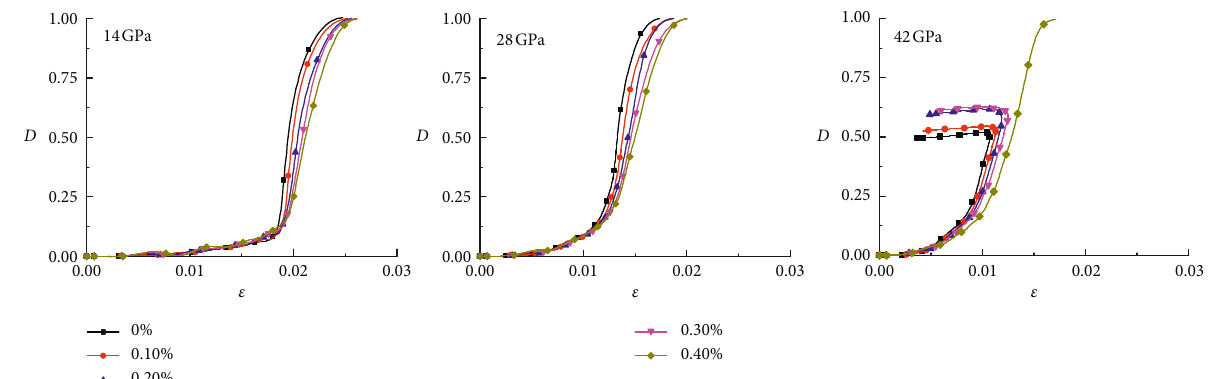
Figure 9: Mechanical damage evolution curves of the rocklike specimen.